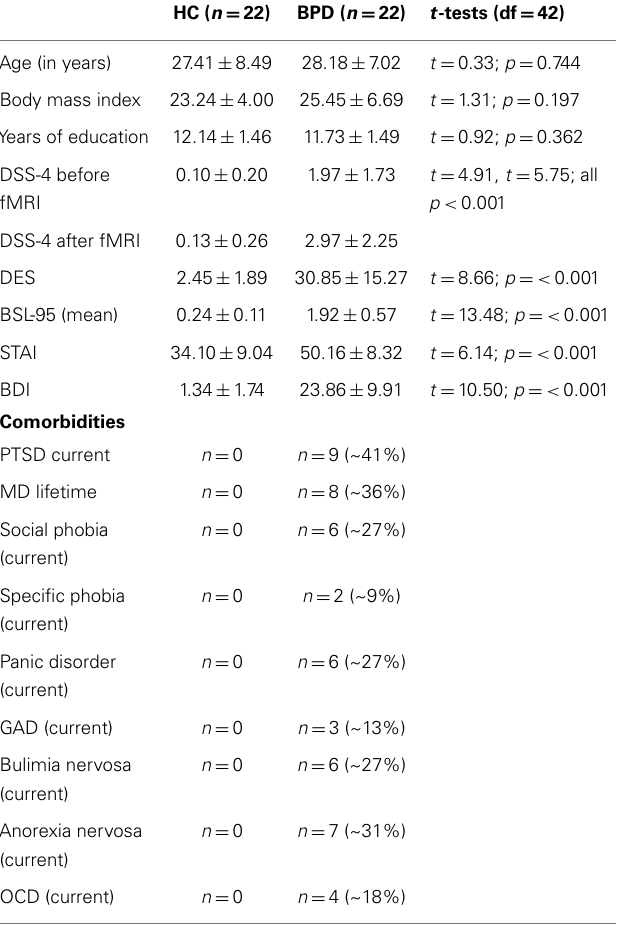
Table 1 | Demographic and clinical variables in healthy controls (HC) and patients with Borderline personality disorder (BPD_D) and results of the univariate analysis of variance (ANOVA) .